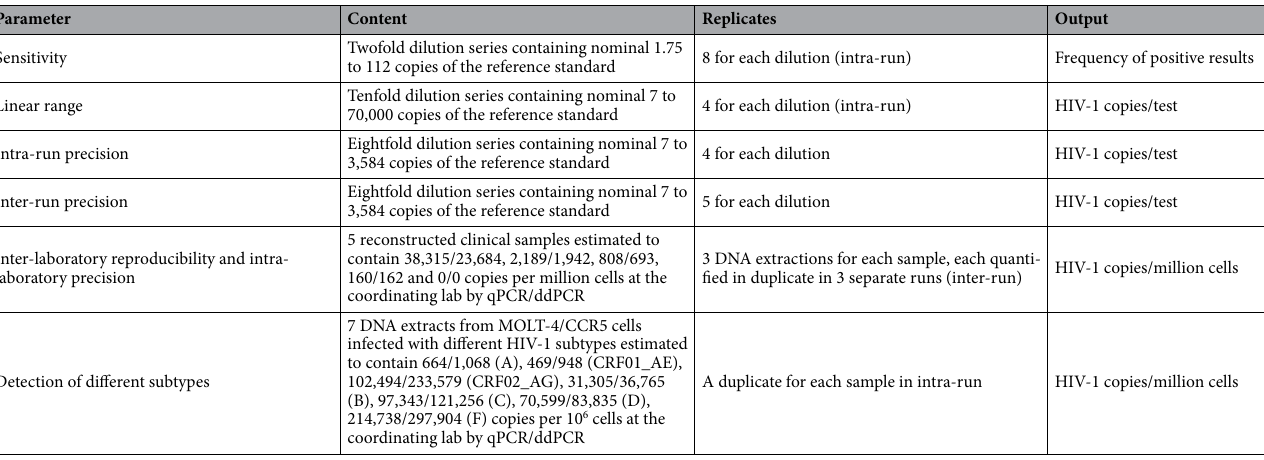
Table 1. Composition of the external quality assurance sample panel and output requested for the different parameters of